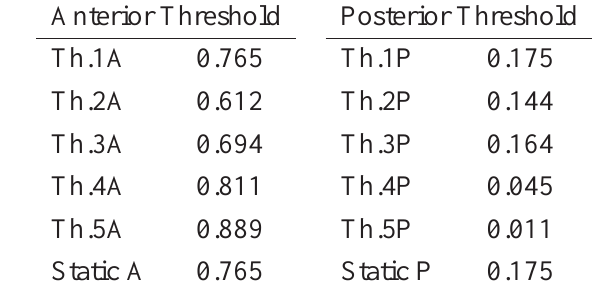
Table 2 . Anterior and posterior step thresholds. The last line is the threshold used for the static step predictor. Note that the threshold 1A and 1P are same as the static step predictors.